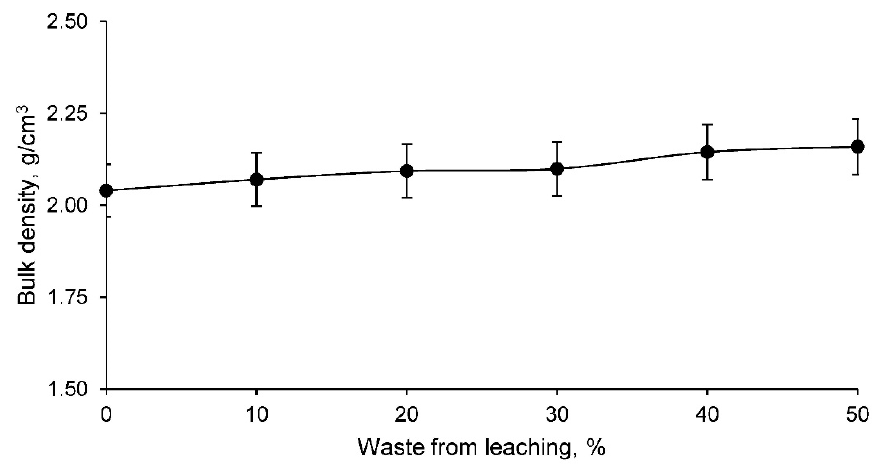
Figure 9. Bulk density of different families of clay-conformed ceramics and leaching residue.